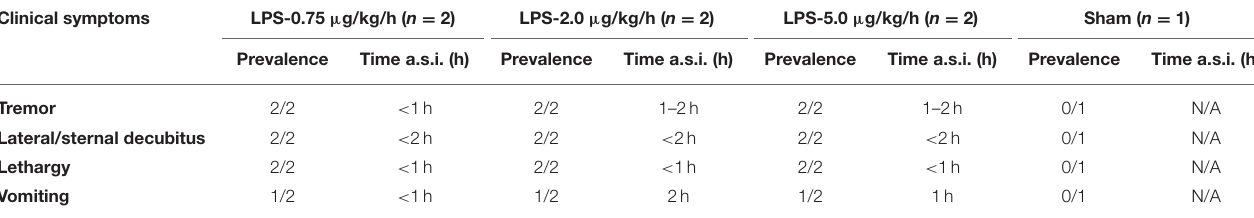
TABLE 1 | Overview of the clinical observations after administration of LPS (0.75; 2.0 or 5.0 µ g/kg/h, n = 2/group) in combination with 6 ml/kg/h of 0.9% NaCl solution to 8-week-old piglets. Clinical symptoms